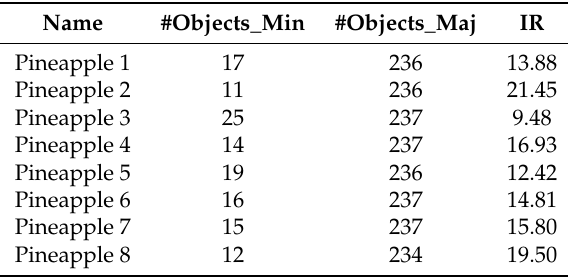
Figure 5. A representation based on time series for the average data of normal class and each of the six faulty classes. Table 2. Summary of micropropagation pineapple databases for detecting pneumatic failures on TIBs, which were introduced in [6].